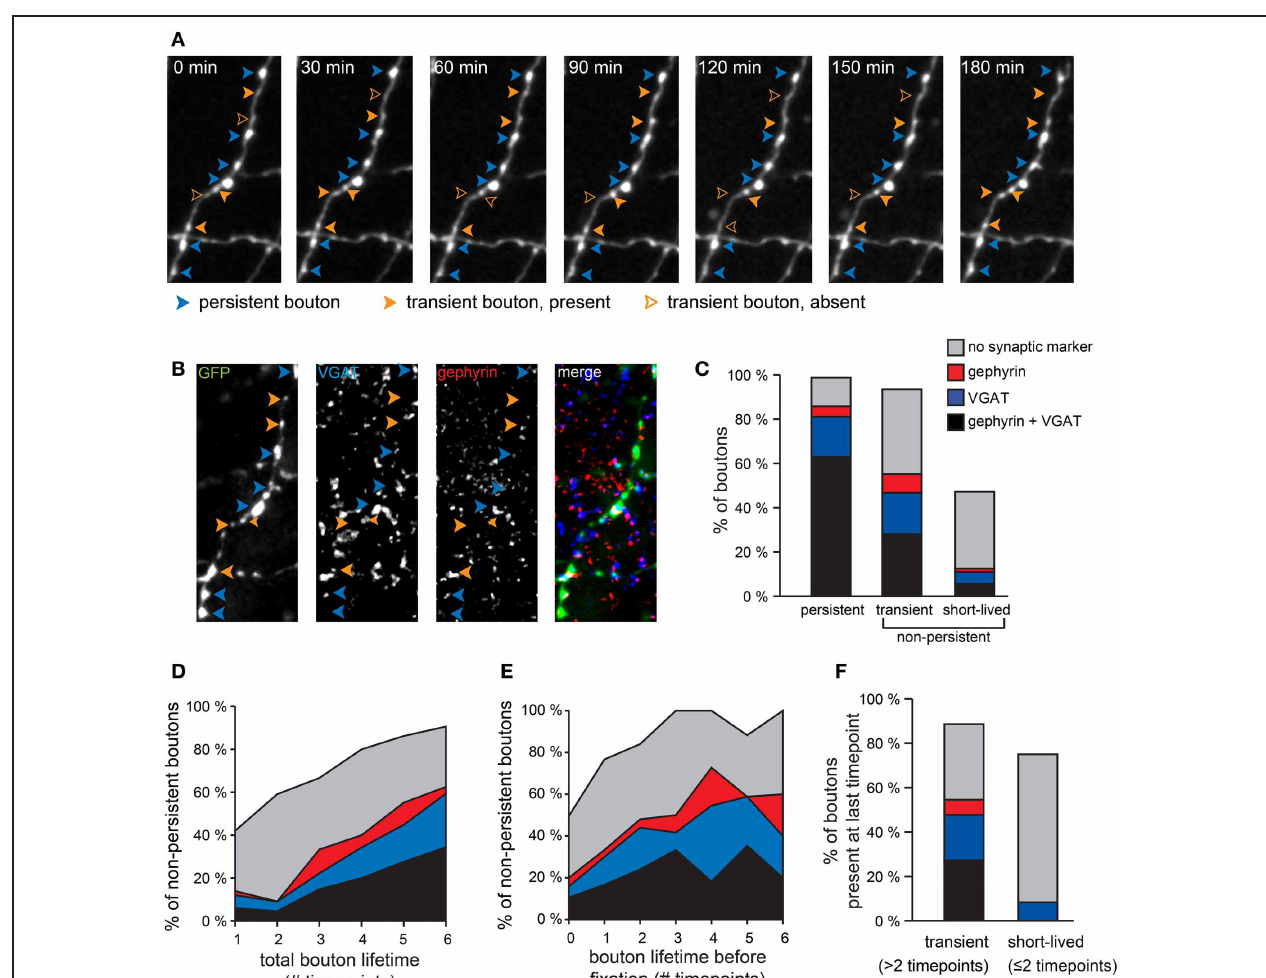
FIGURE 2 | Different synaptic marker content for persistent and non-persistent GABAergic boutons. (A) Persistent and non-persistent boutons along an individual GABAergic axon were identified and analyzed. Blue arrowheads: persistent boutons; filled and open orange arrowheads: present and absent non-persistent boutons, respectively. (B) Immunohistochemistry [vesicular GABA transporter (VGAT, blue), gephyrin (red), GFP (green)] of the same axon. (C) Percentage of boutons with synaptic markers (color code as in B ) for each bouton category. Data from 470 persistent, 123 transient, and 72 short-lived boutons from two separate experiments. (D) Fraction of non-persistent